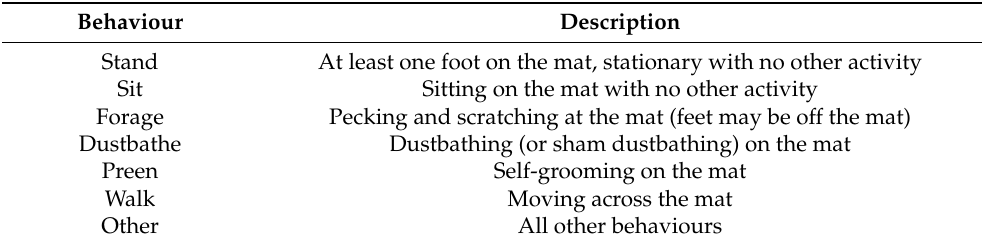
Table 2. Ethogram of Behaviours Observed on the Scratch Mats. Any Part of the Bird Touching the Mat Counted as Being ‘on the Mat’. Behaviour Description Stand At least one foot on the mat, stationary with no other activity Sit Sitting on the mat with no other activity Forage Pecking and scratching at the mat (feet may be off the mat) Dustbathe Dustbathing (or sham dustbathing) on the mat Preen Self-grooming on the mat Walk Moving across the mat Other All other